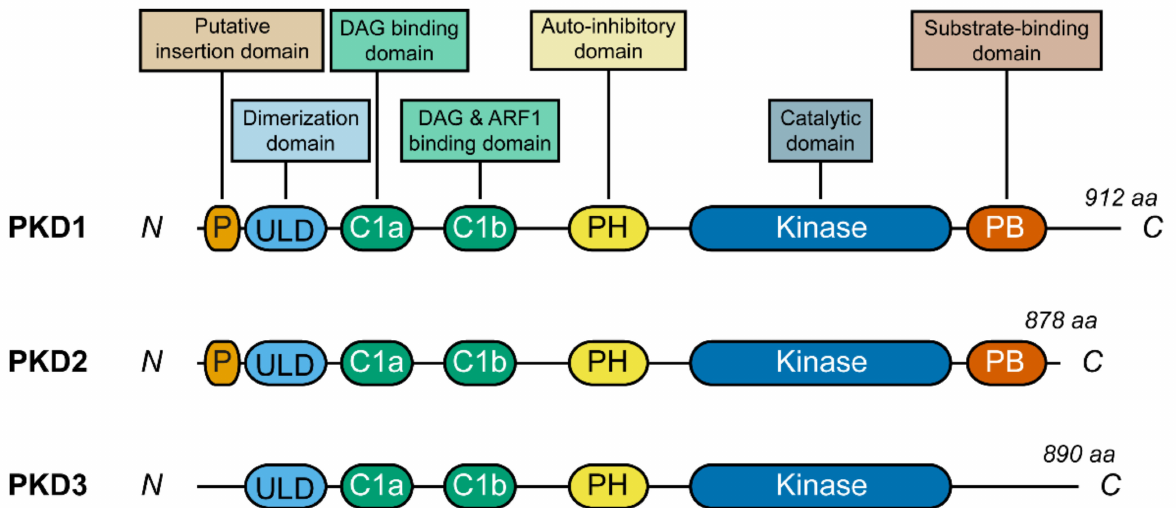
Figure 1. Schematic representation of human PKD domain structure. The three members of the human PKD family of protein kinases (PKD1, PKD2, and PKD3) have a similar domain structure. The major domains and their functions are depicted here. P: putative insertion domain; ULD: ubiquitin-like domain; C1a and C1b: cysteine-rich zinc-finger regions a and b; PH: pleckstrin homology domain; PB: postsynaptic density-95/discs large/zonula occludens-1 (PDZ)-binding